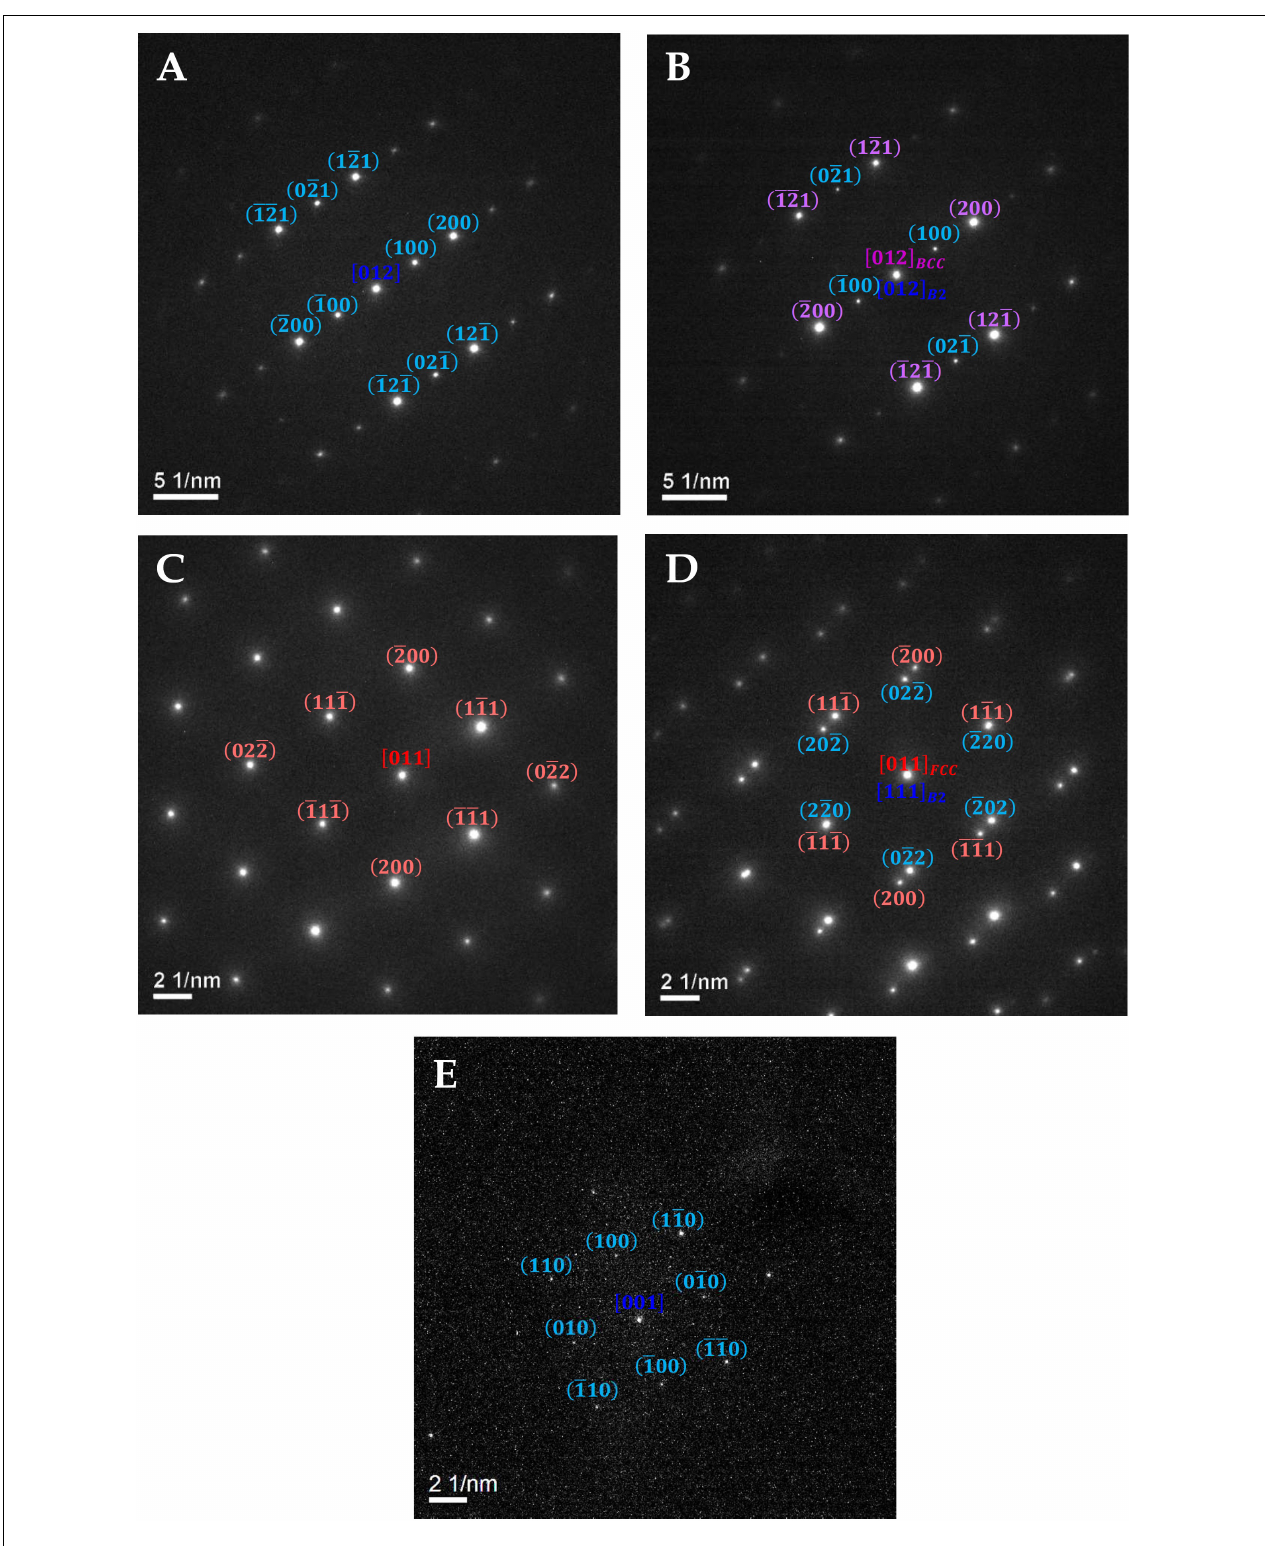
FIGURE 14 | SAED patterns in the homogenized and aged (930 ◦ C) AlCrFe 2 Ni 2 alloy – obtained from (A) the B2 parent phase in Z.A. < 210 > ; (B) a BCC globule in Z.A. < 210 > inside the B2 phase; (C) the FCC parent phase in Z.A. < 110 > ; (D) a B2 platelet in Z.A. < 111 > inside the FCC parent phase in Z.A. < 110 > exemplifying the Kurdjumov-Sachs orientation relationship; (E) a B2 platelet in Z.A. < 001 > inside the FCC parent phase.